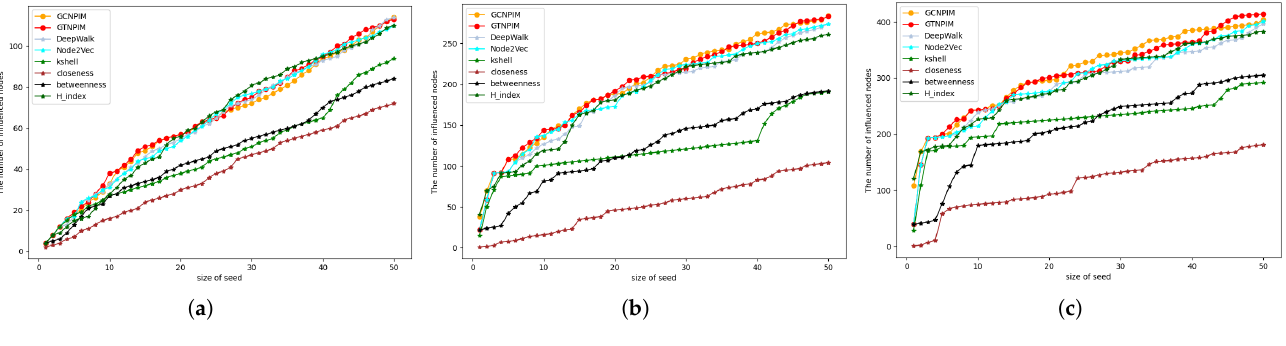
Figure 8. The spread of influence with different spreading probabilities and number of seeds for different algorithms under the IC model on BCP dataset. ( a – c ) Diffusion probabilities of 0.1, 0.3 and 0.5 respectively.